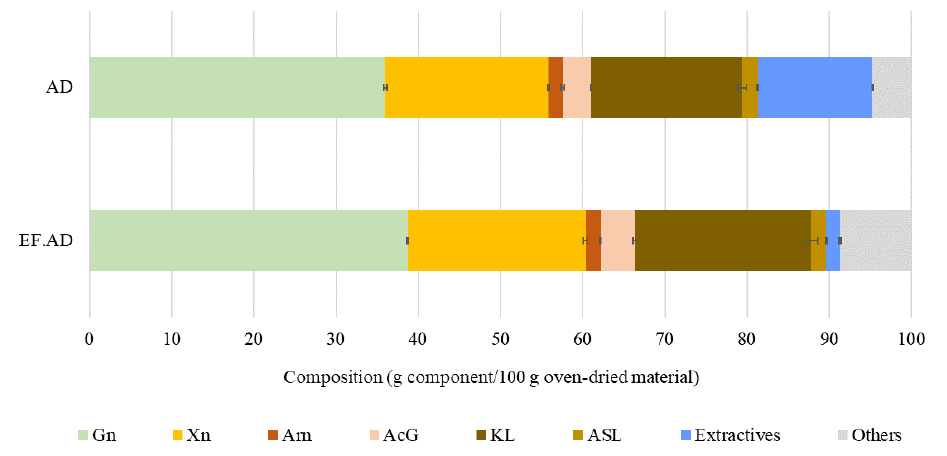
Figure 1. Average composition of AD and water-extracted AD (EF.AD), expressed as g of component per 100 g oven-dried material ± standard deviation. Nomenclature: anhydroglucose units, G n ; anhydroxylose units, X n ; anhydroarabinose units, Ar n ; acetyl groups, AcG; Klason Lignin, KL; Acid Soluble Lignin,